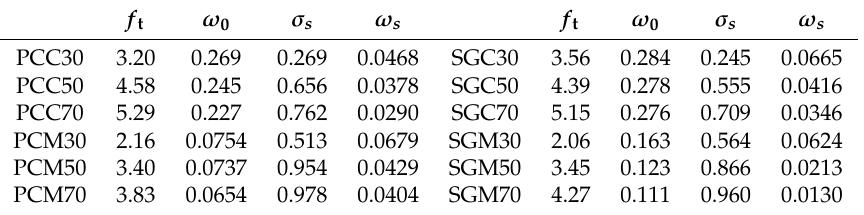
Table 5. Bilinear softening law parameters of the PC and SG concrete and